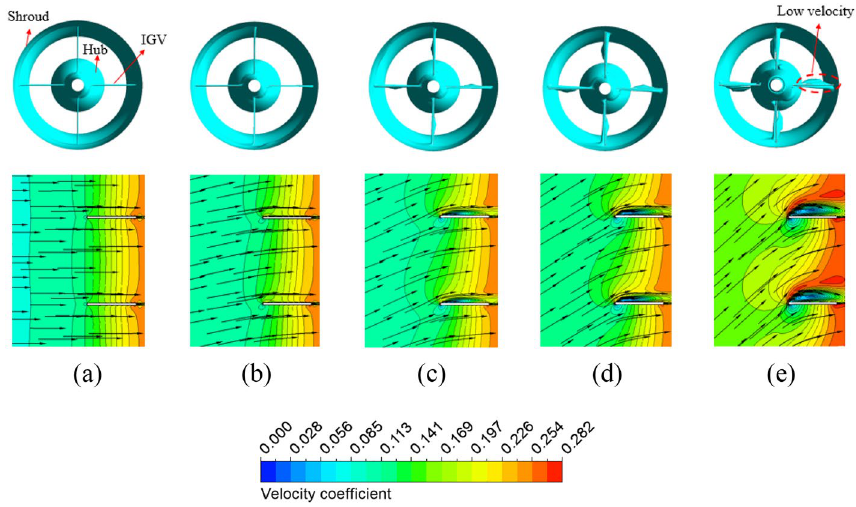
Figure 10. Low-velocity zone and velocity distribution at 50% span of the IGV passage with different pre-swirl intensities. ( a ) 0%, ( b ) 5%, ( c ) 10%, ( d ) 15%, and ( e ) 30%.